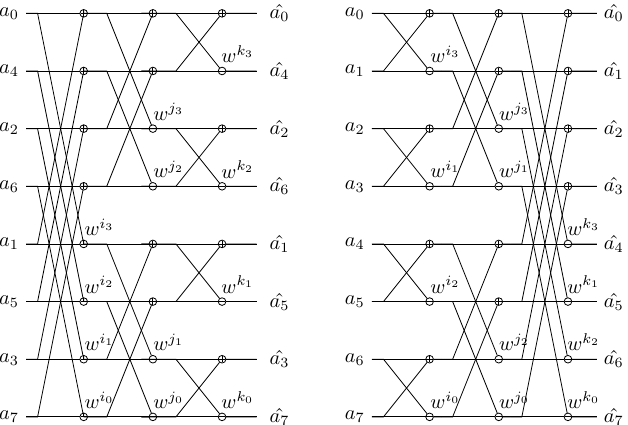
Figure 3: Butterfly operation with bit-reversed twiddle